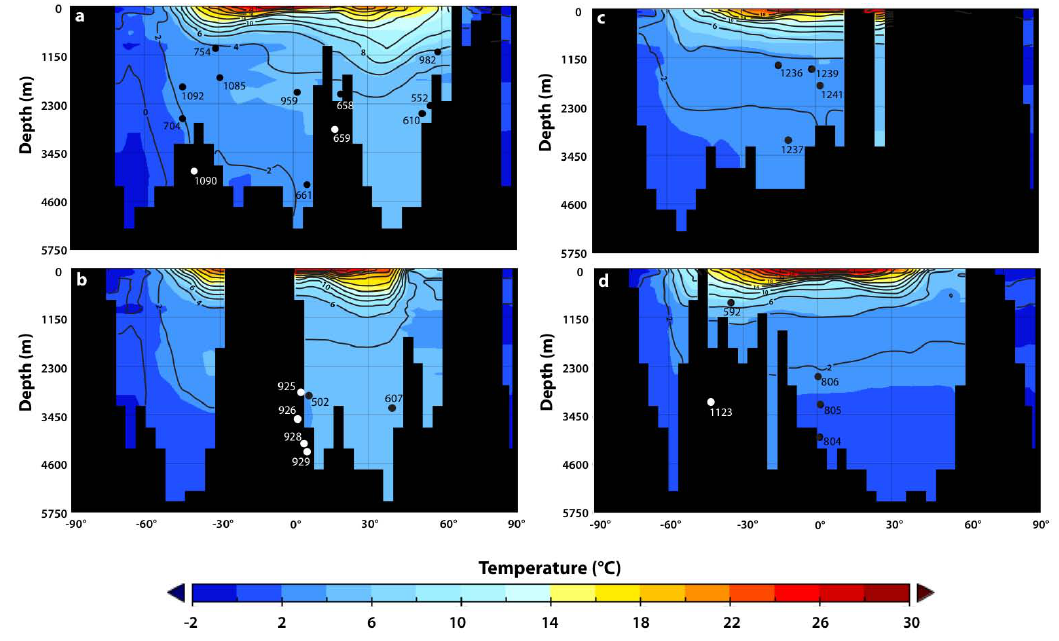
Fig. 2. Longitudinal profiles of ocean temperature from transects at (a) 15 ◦ W, (b) 45 ◦ W, (c) 90 ◦ W and (d) 165 ◦ E. All temperatures are shown in ◦ C. Contour interval is 2 ◦ C. Black contour lines show modern temperature overlaid on coloured regions showing the mid-Pliocene reconstruction. The change in temperature can be surmised by comparing the colour contours to the black overlaid contour lines. For example, in panel (d) , Site 806 is slightly cooler than 2 ◦ C in the modern ocean but was slightly warmer than 2 ◦ C during the mid-Pliocene (modified from Dowsett et al.,